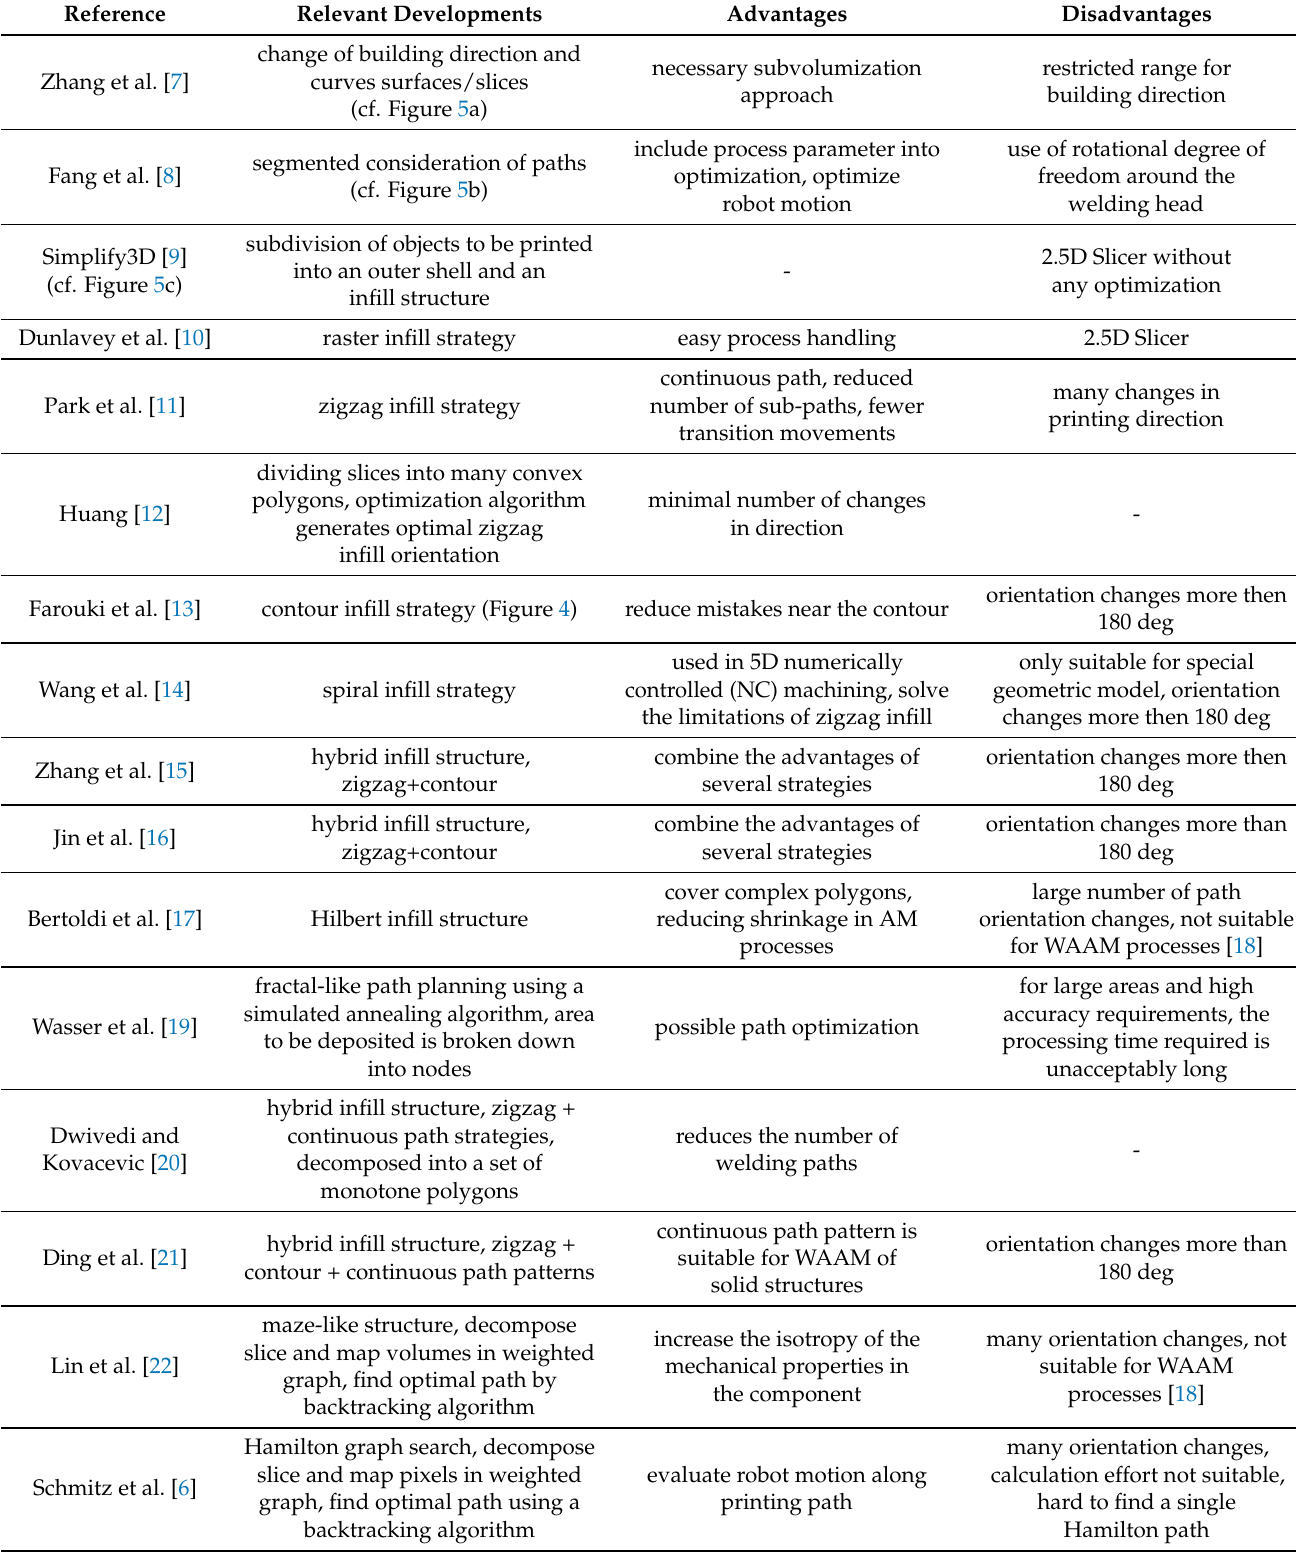
Table 1. Summary of the state of the art of path planning algorithms. Advantages and disadvantages are summarized in the context of robotic MDAM using